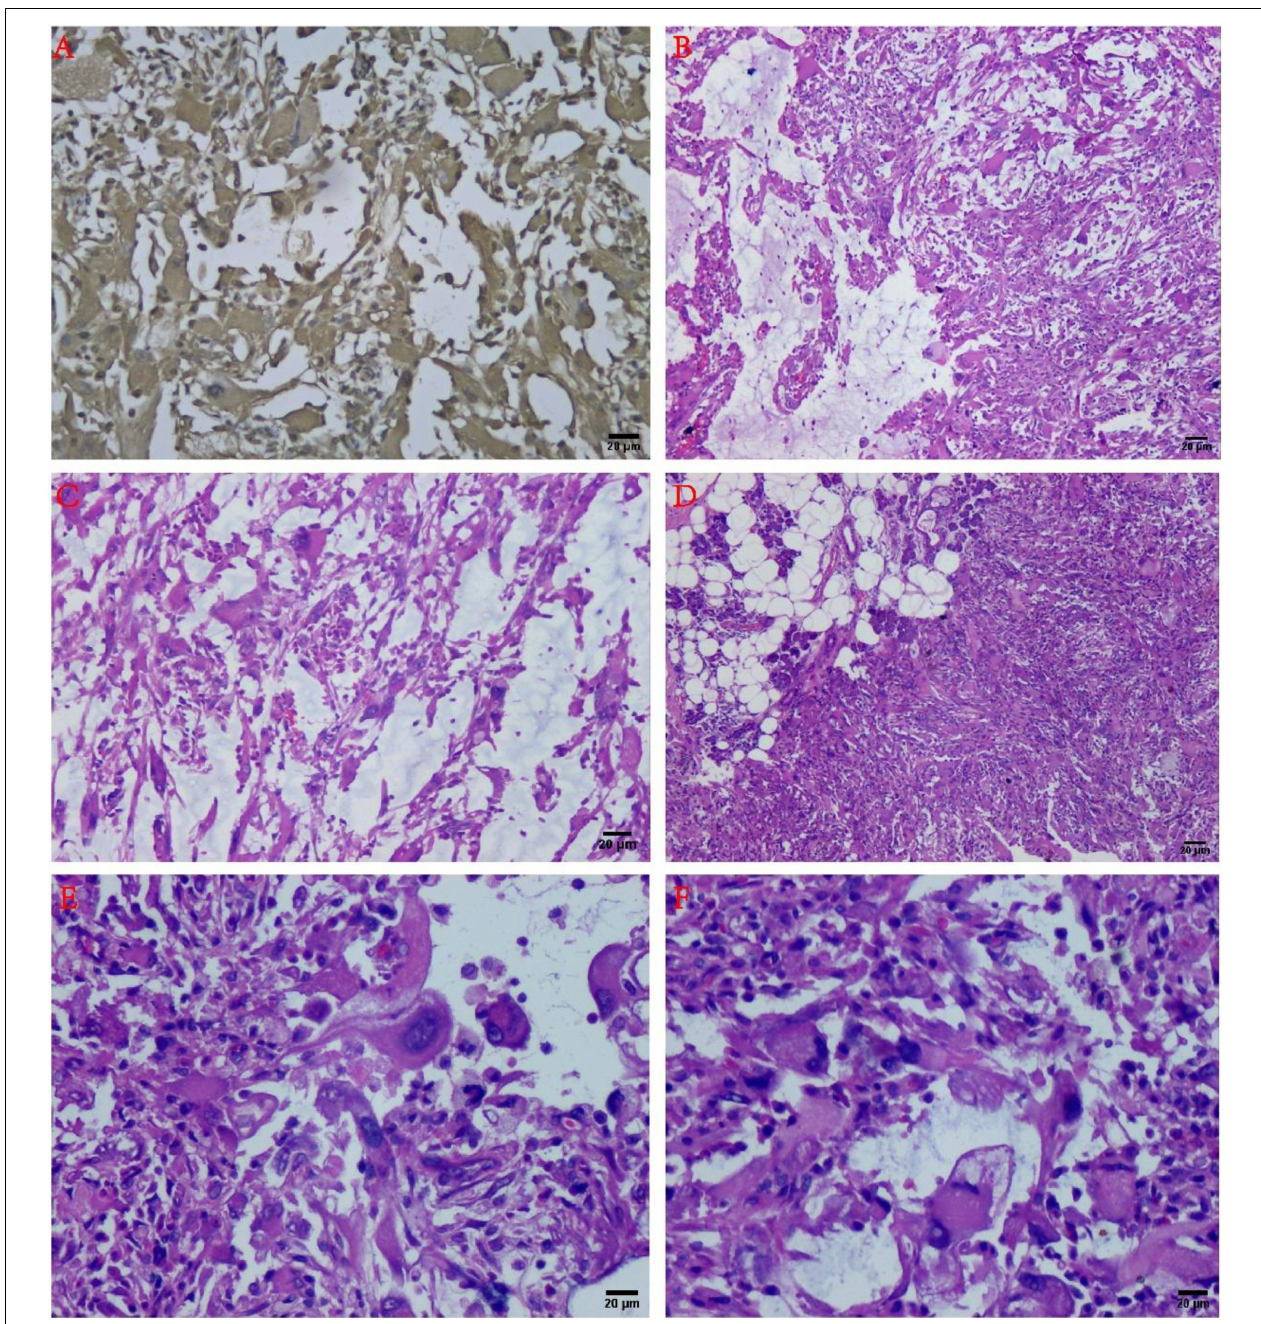
FIGURE 2 | Histology and immunohistochemistry of the tumor. (A) Immunohistochemical results showed Vimentin diffuse positive (+) (IHC staining, × 100). (B) The tumor consisted of the mucous area and the fibrous area with inflammatory cell infiltration in the mucus-like area, and the various fusiform cells can be connected to each other to form a network structure (H&E staining, × 100). (C) At the junction of the mucous area and the fiber area, inflammatory cell infiltration could be observed (H&E staining, × 100). (D) The tumor can be infiltrated into the parotid tissue (H&E staining, × 100). (E) Large malformed cells with large nucleoli can be noted (H&E staining, × 200). (F) The “inclusion body” nucleolus resembling Reed-Sternberg cells has been recognized as one of the characteristics of mucinous inflammatory fibroblastic sarcoma (H&E staining, × 200).